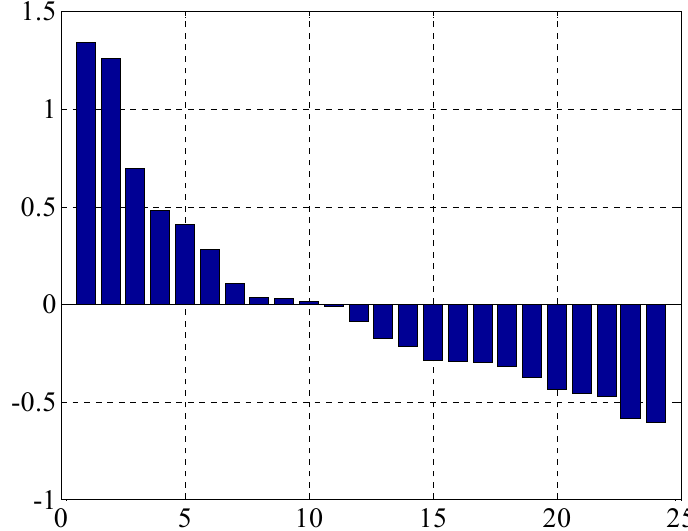
Figure 29. The ranking of performance index